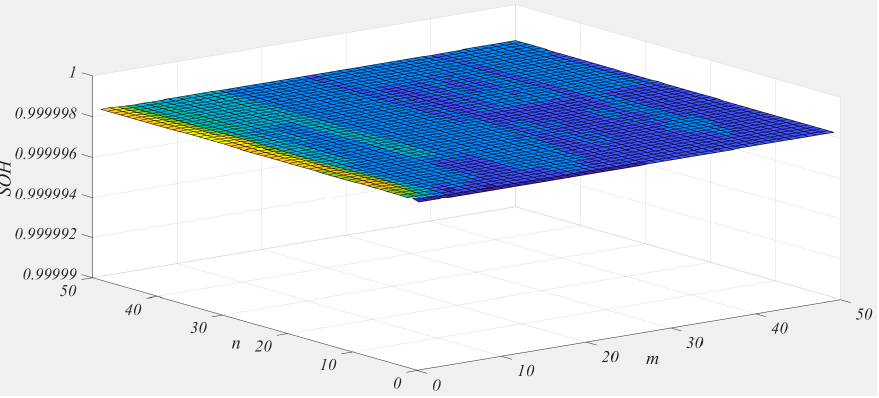
Figure 8. Topology 1 battery pack SOH change trend affected by R 0 .